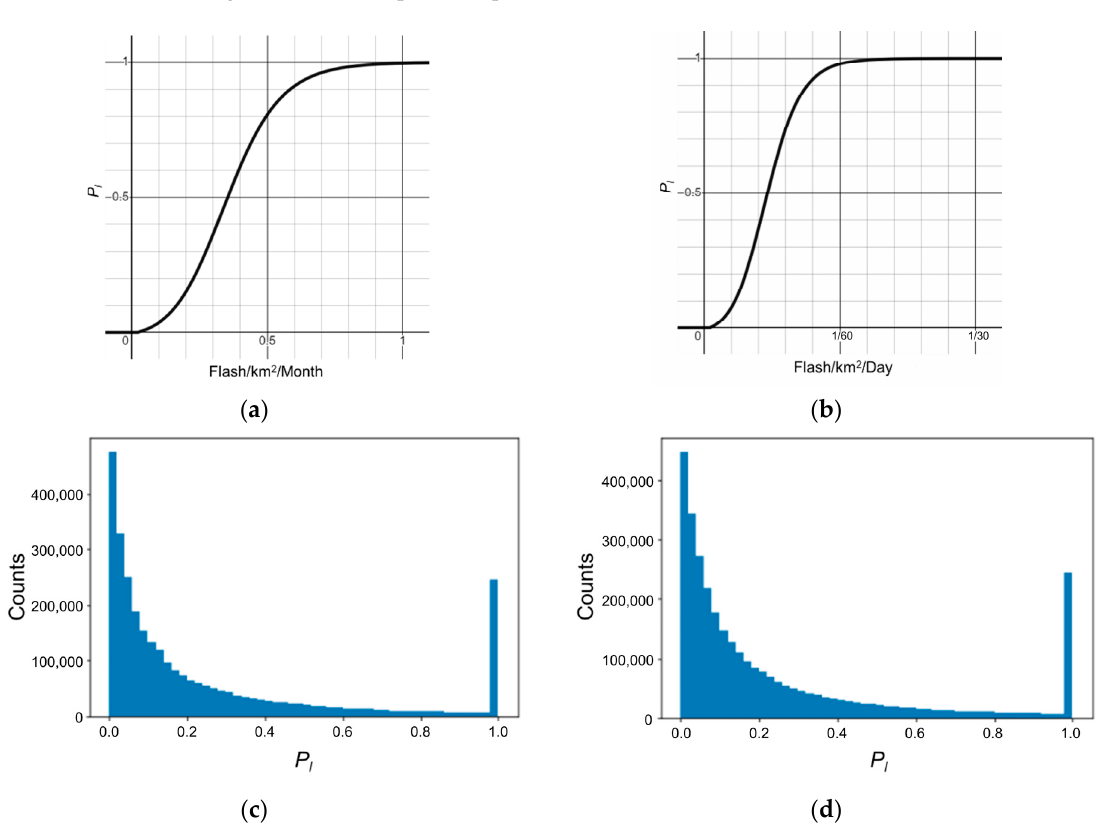
Figure 8. Optimization of the ignition probability conditional on lightning frequency: ( a ) original probabilities at a global scale, ( b ) optimized probabilities for South Korea, ( c ) probability distribution calculated with monthly dataset and the original parameters, ( d ) probability distribution calculated with daily dataset and the optimized parameters.